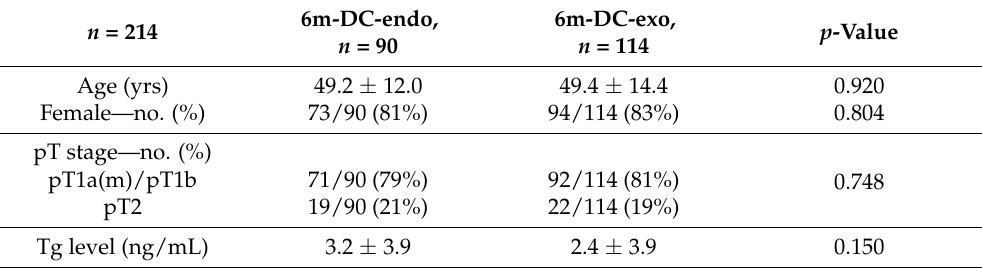
Table 2. Patient characteristics of subgroups (6m-DC-endo vs.